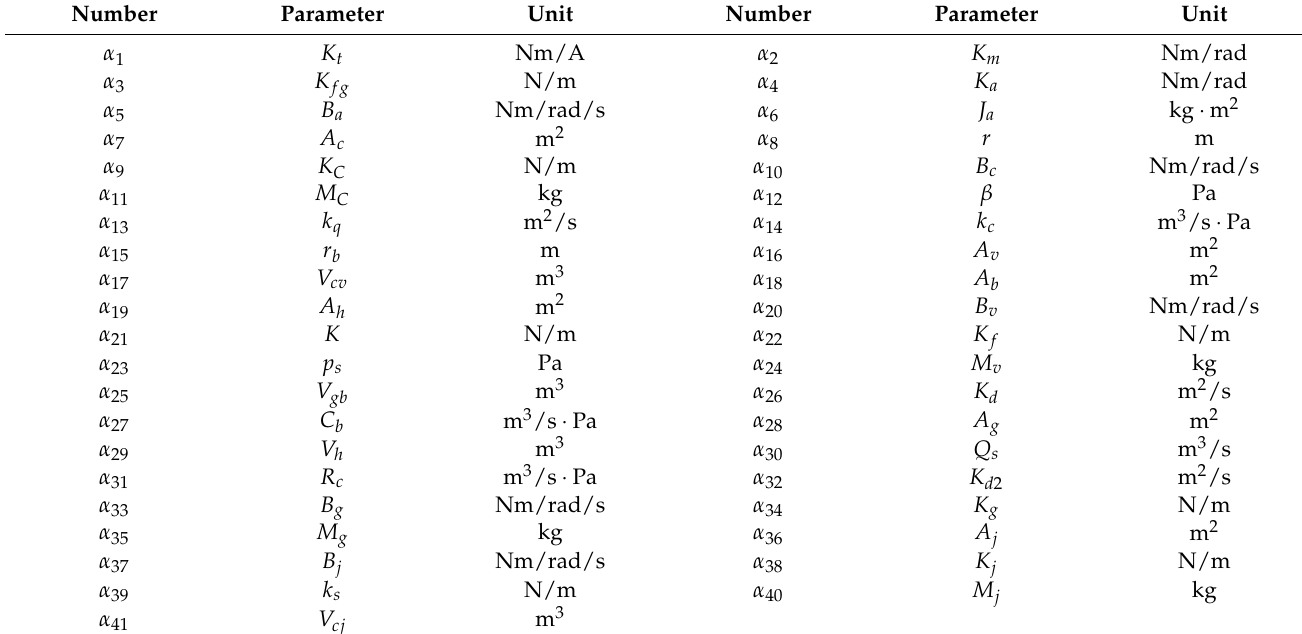
Table 2. The parameters of α